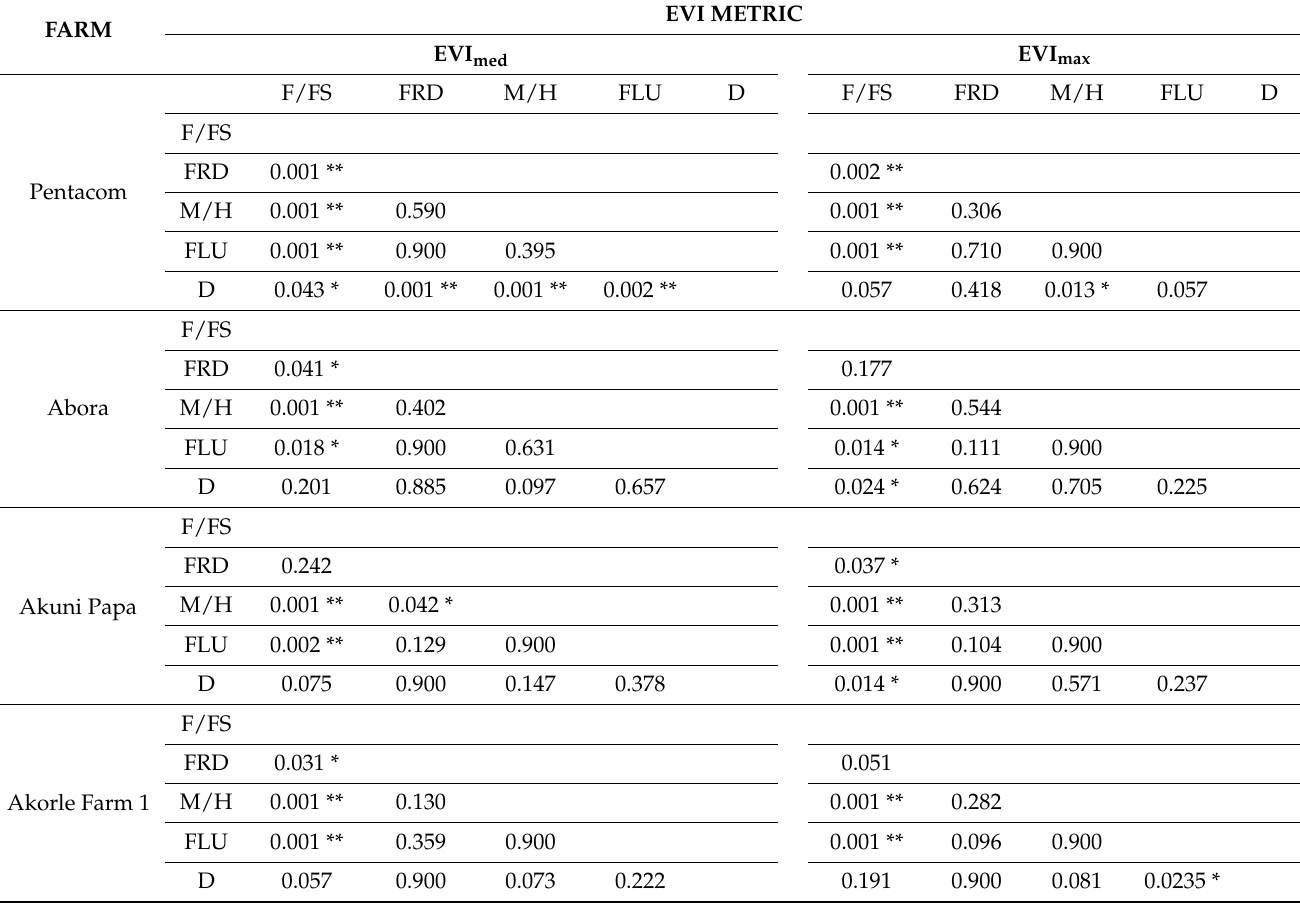
Table 3. Results of the Tukey HSD test conducted on the phenology stages of the four